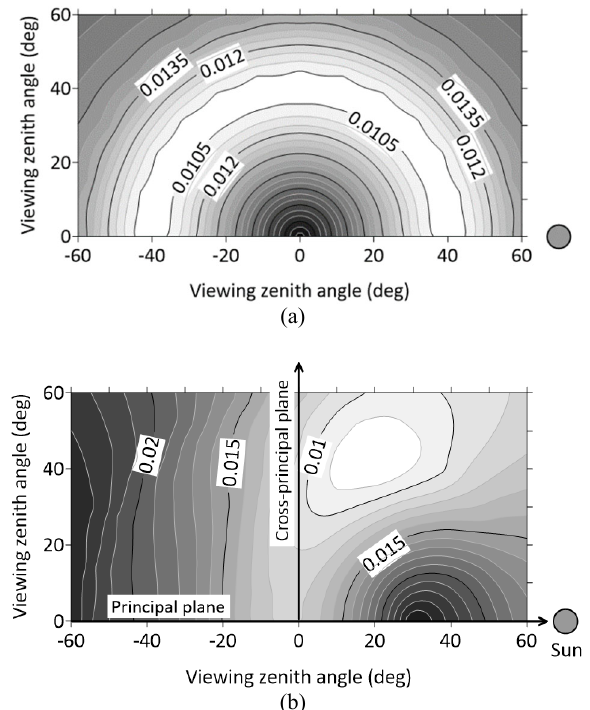
Figure 4. Contour maps of root-mean-square error (RMSE) of multi-regression model for IGBP LC16, barren or sparsely vegetated. The RMSE was calculated by using the residual between the simulated and estimated albedo. The solar zenith angle was set to 0° and 30° for (a) and (b),